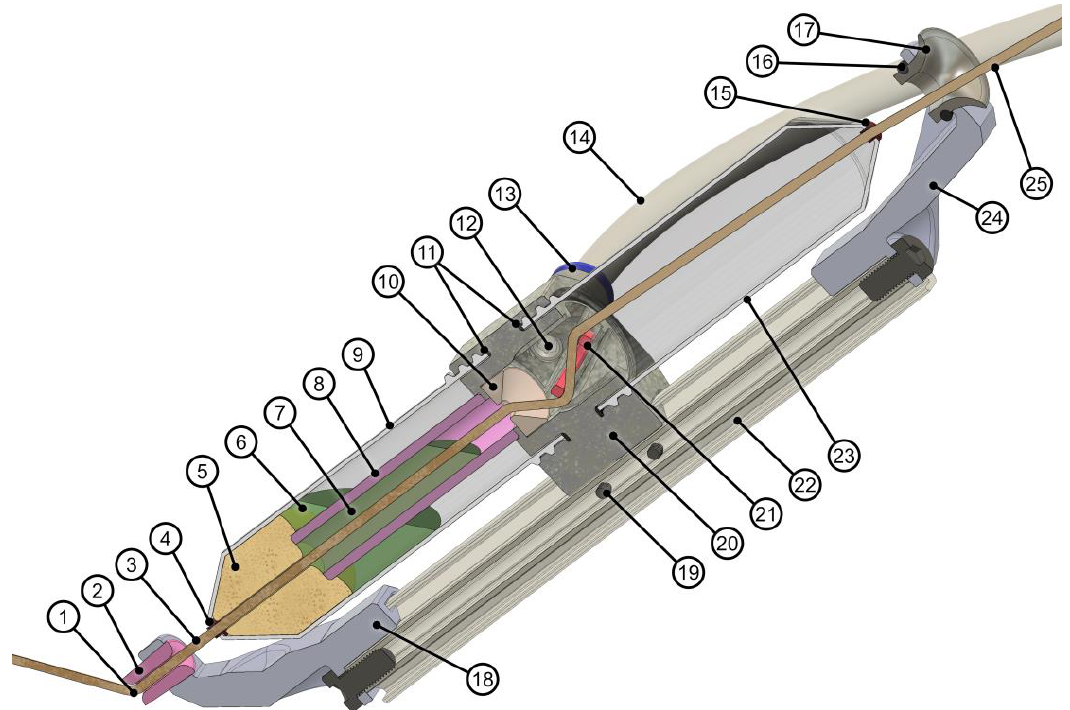
Figure 4. Sectional view of the developed winding head in CAD. 1: tool center point, 2: conical ce-